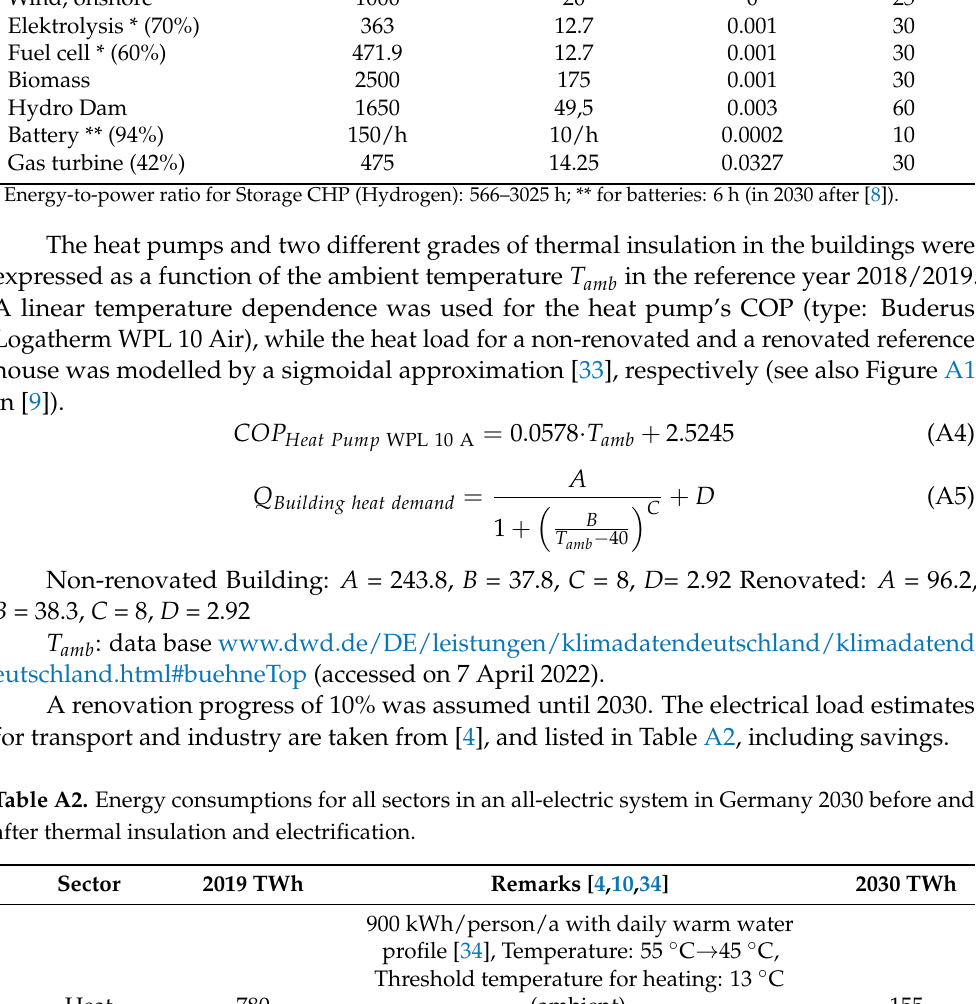
Table A1. Costs for power generation and conversion for 2030 after [8] pp. 282–285 in “Global Energy System based on 100% Renewable Energy”, where the corresponding costs for the fuel cells are adopted from average costs in [12], where it is an increase of 30% versus the electrolysis average. OPEX var Technology CAPEX € /kWel OPEX fix kW/a € /kWh/a (Conversion Efficiency) Estim. for 2030 390